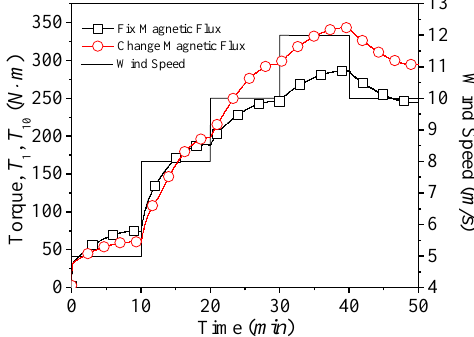
Figure 14. Torque variation for the input shaft.